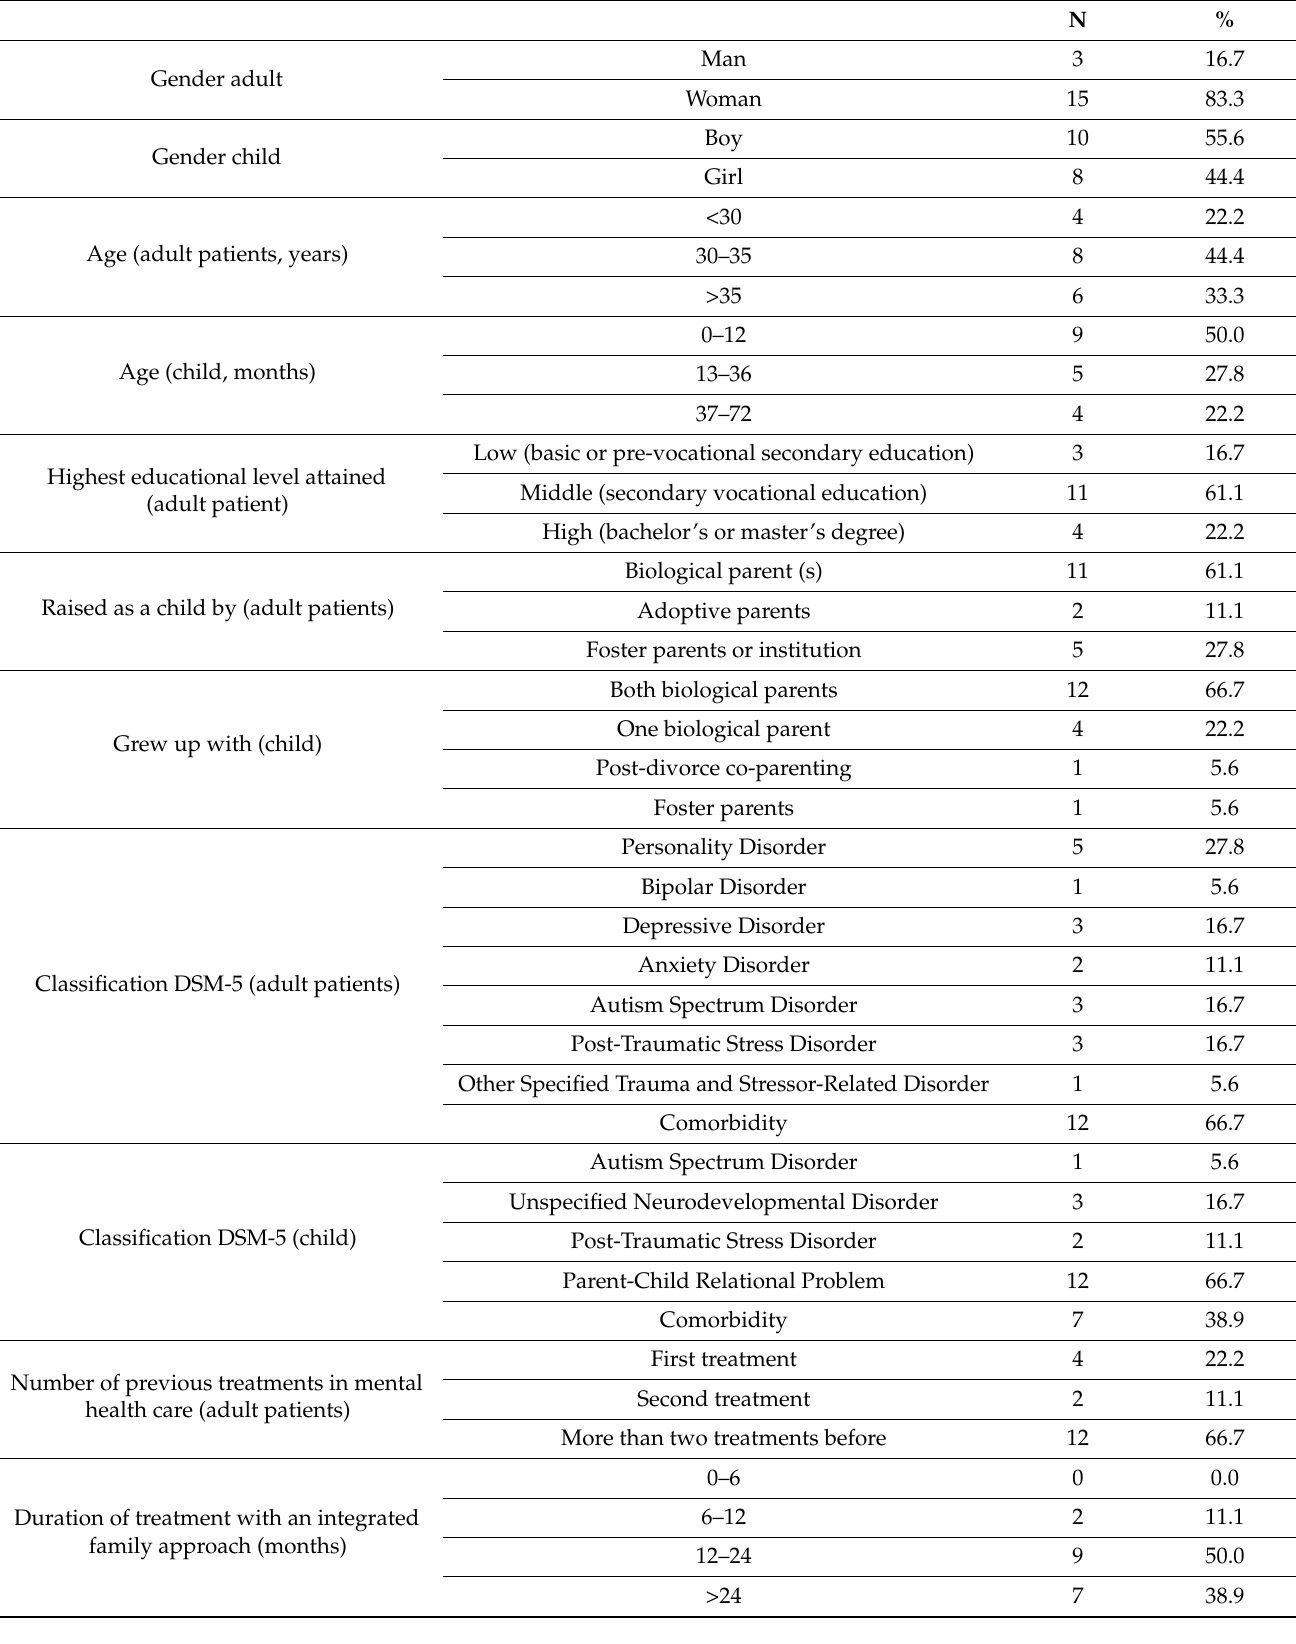
Table 1. Characteristics of adult patients (N = 18) and their children (N =